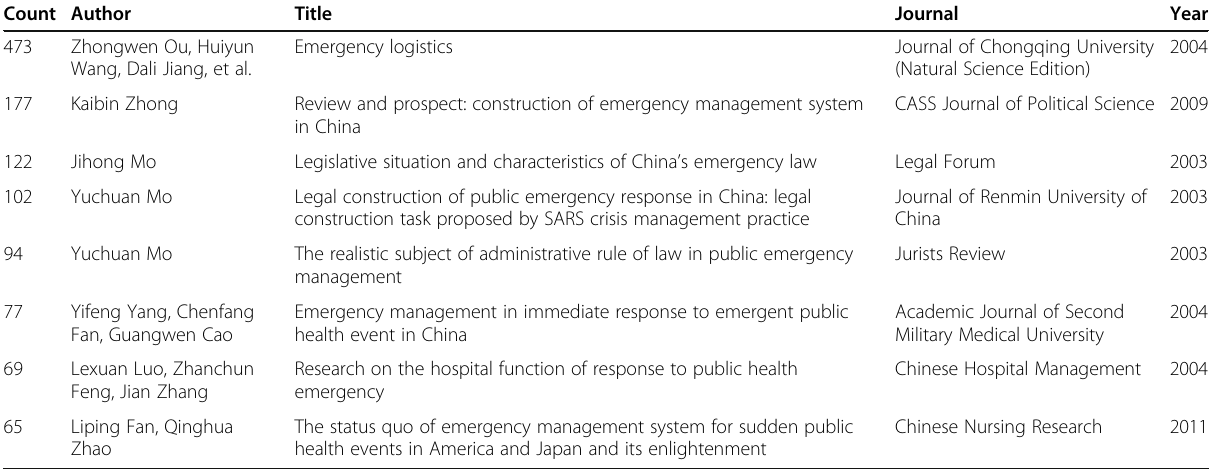
Table 3 Top 8 cited articles of Chinese